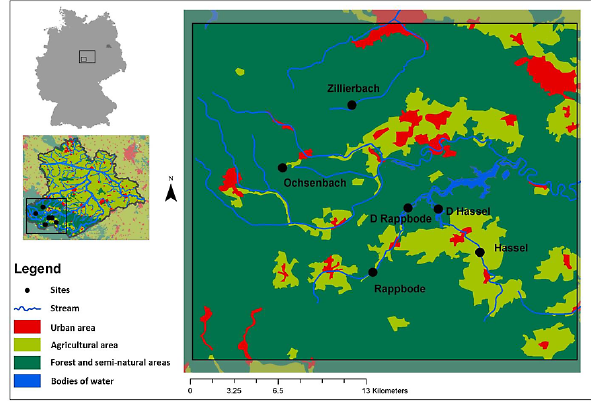
Fig. 1. Map of the investigation area.